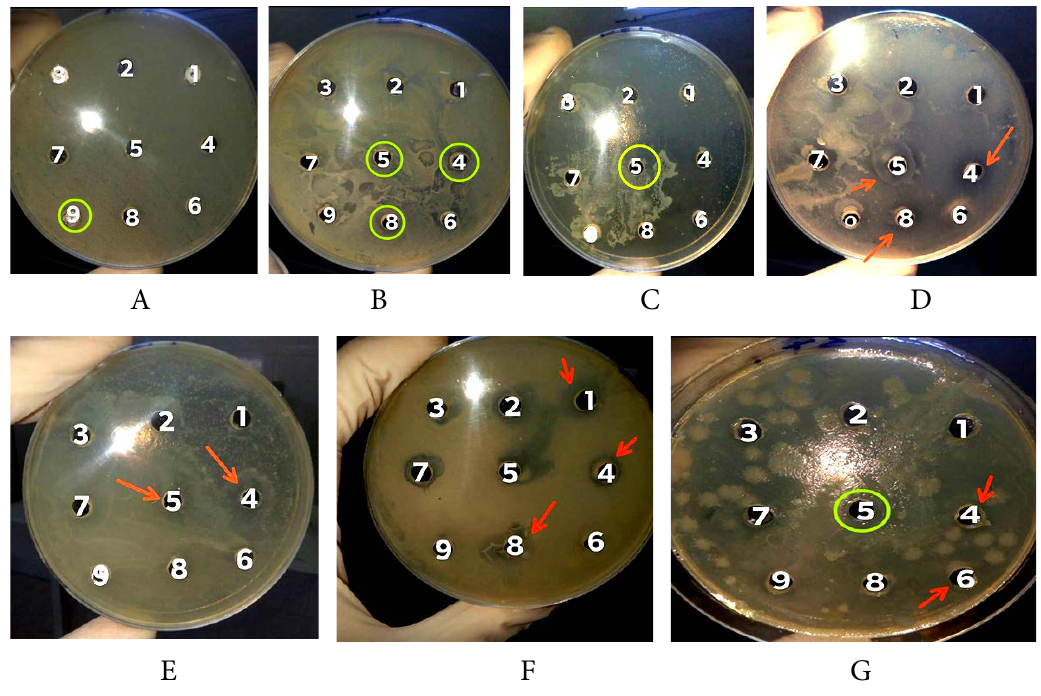
Fig. 3. Inhibitions obtained against A: Listeria innocua clip , B: Pseudomonas aeruginosa , C: Klebseilla pneumoniae , D: Escherichia coli, E: Salmonella, F: Bacillus cereus , G: Staphylococcus aureus